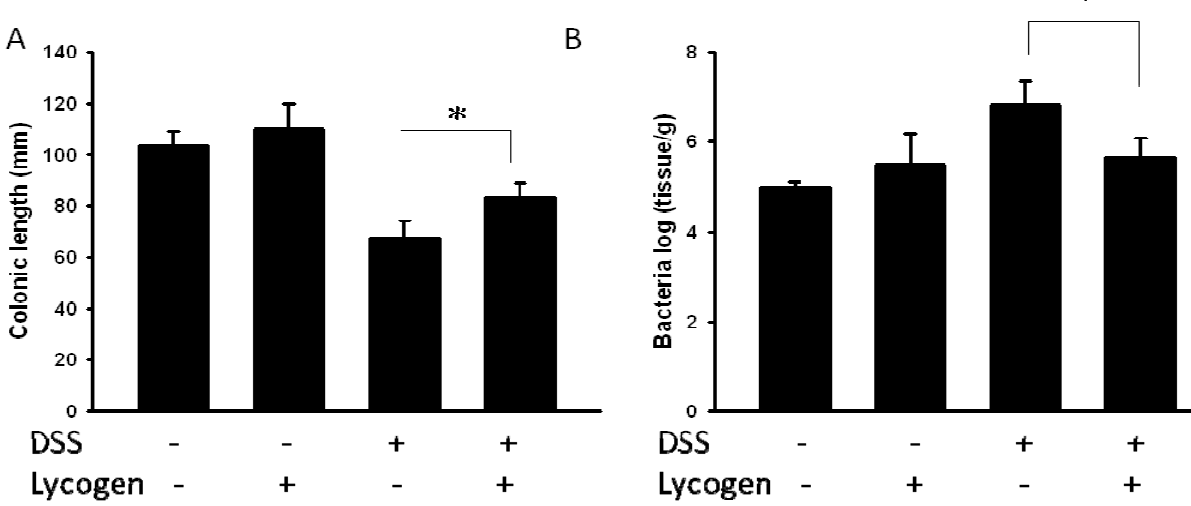
Figure 3. Lycogen™ inhibited DSS-induced colonic shorting and bacterial flora. ( A ) The mice with colitis were orally administered with Lycogen™ (1 mg/kg) for six consecutive days after DSS induction and the colon lengths were determined at day 6 (means ± SD, n = 4). ( B ) The mice with colitis were orally administered with Lycogen™ (1 mg/kg) for six consecutive days after DSS induction and the amount of bacteria in colon was